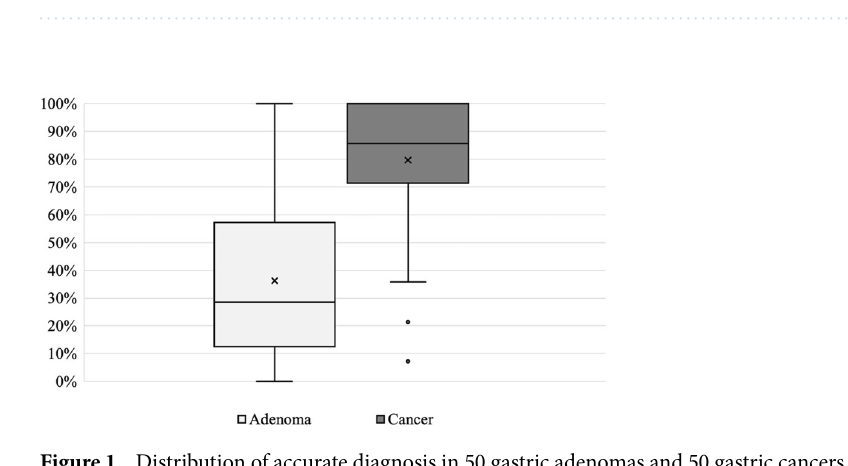
Table 4. Association between the accuracy of C-WLI + M-NBI and background factors. C-WLI + M-NBI accuracy represents the mean of endoscopic diagnoses consistent with pathological diagnoses.